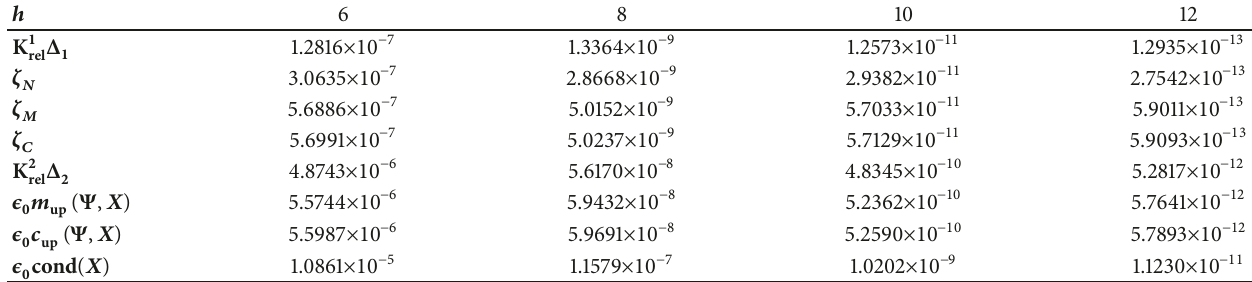
Table 4: Condition numbers and relative upper perturbation bounds for Example 3 evaluated at ℎ = {6,8,10,12} and 𝑛 = 3 . ℎ